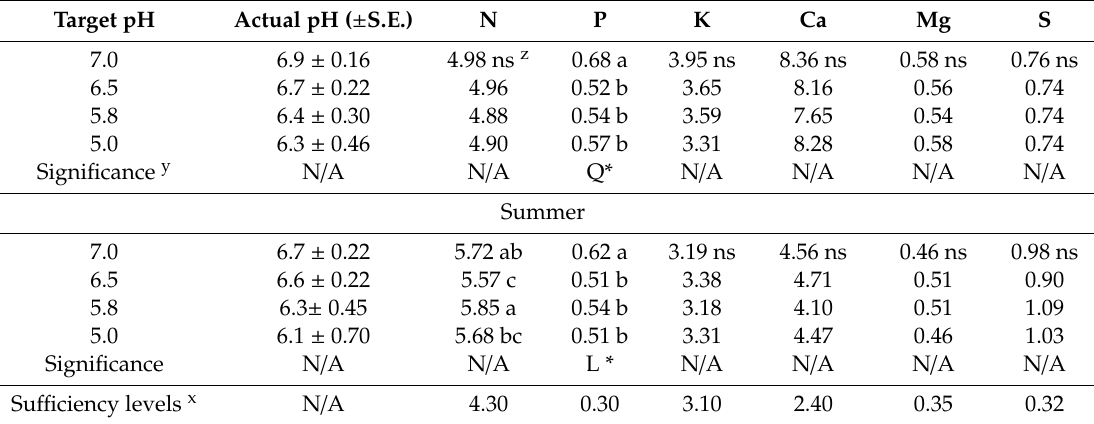
Table 3. Midseason foliar analysis of macronutrient content as percentage of dry matter for aquaponic cucumbers at four pH